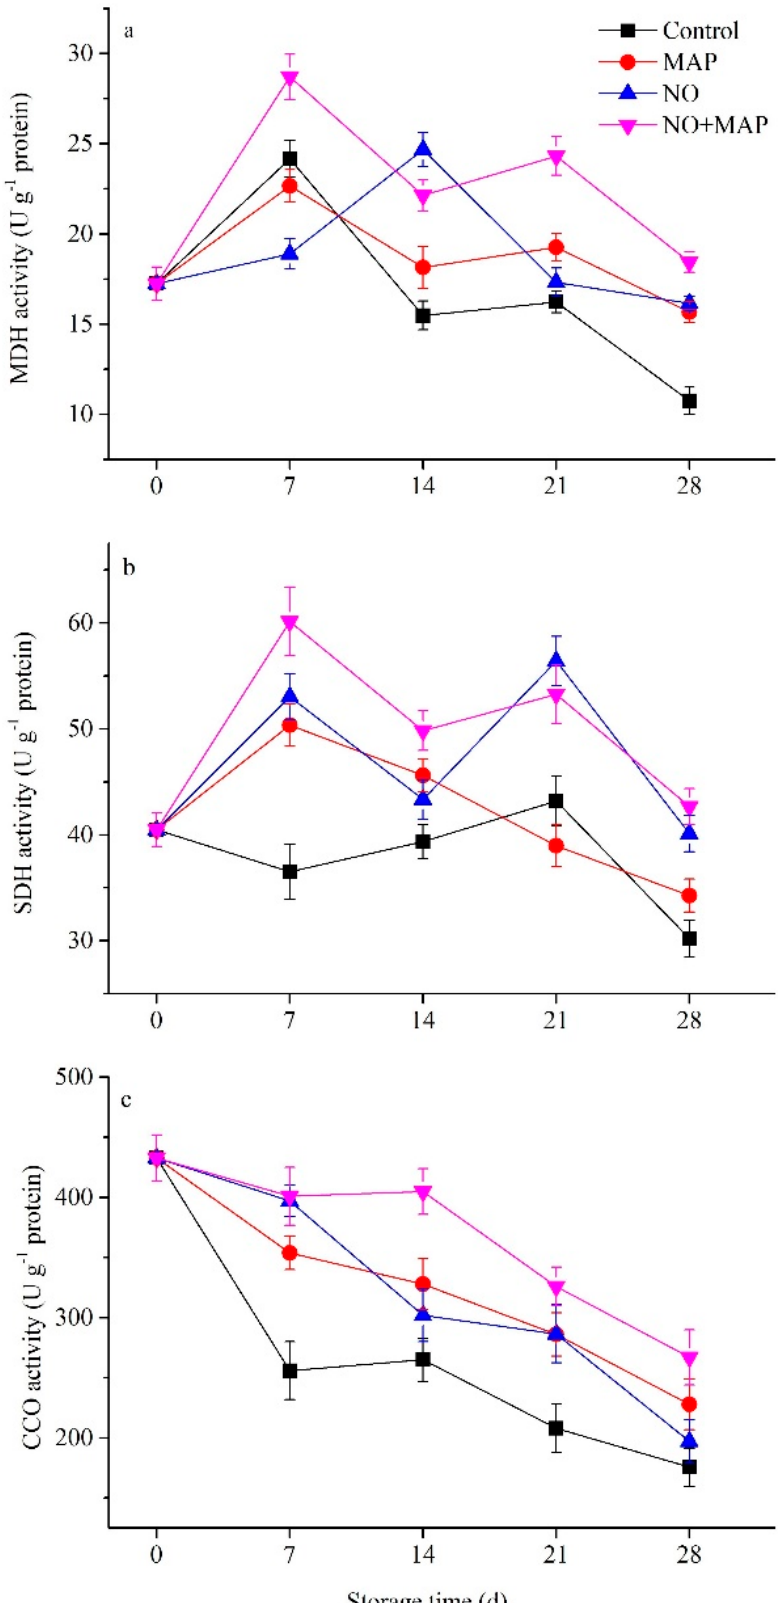
Figure 6. Effects of NO and MAP treatment on activities of MDH ( a ), SDH ( b ), and CCO ( c ) in water bamboo shoots stored at 4 °C for 0, 7, 14, 21, and 28 d. Values are presented as mean ± SD.